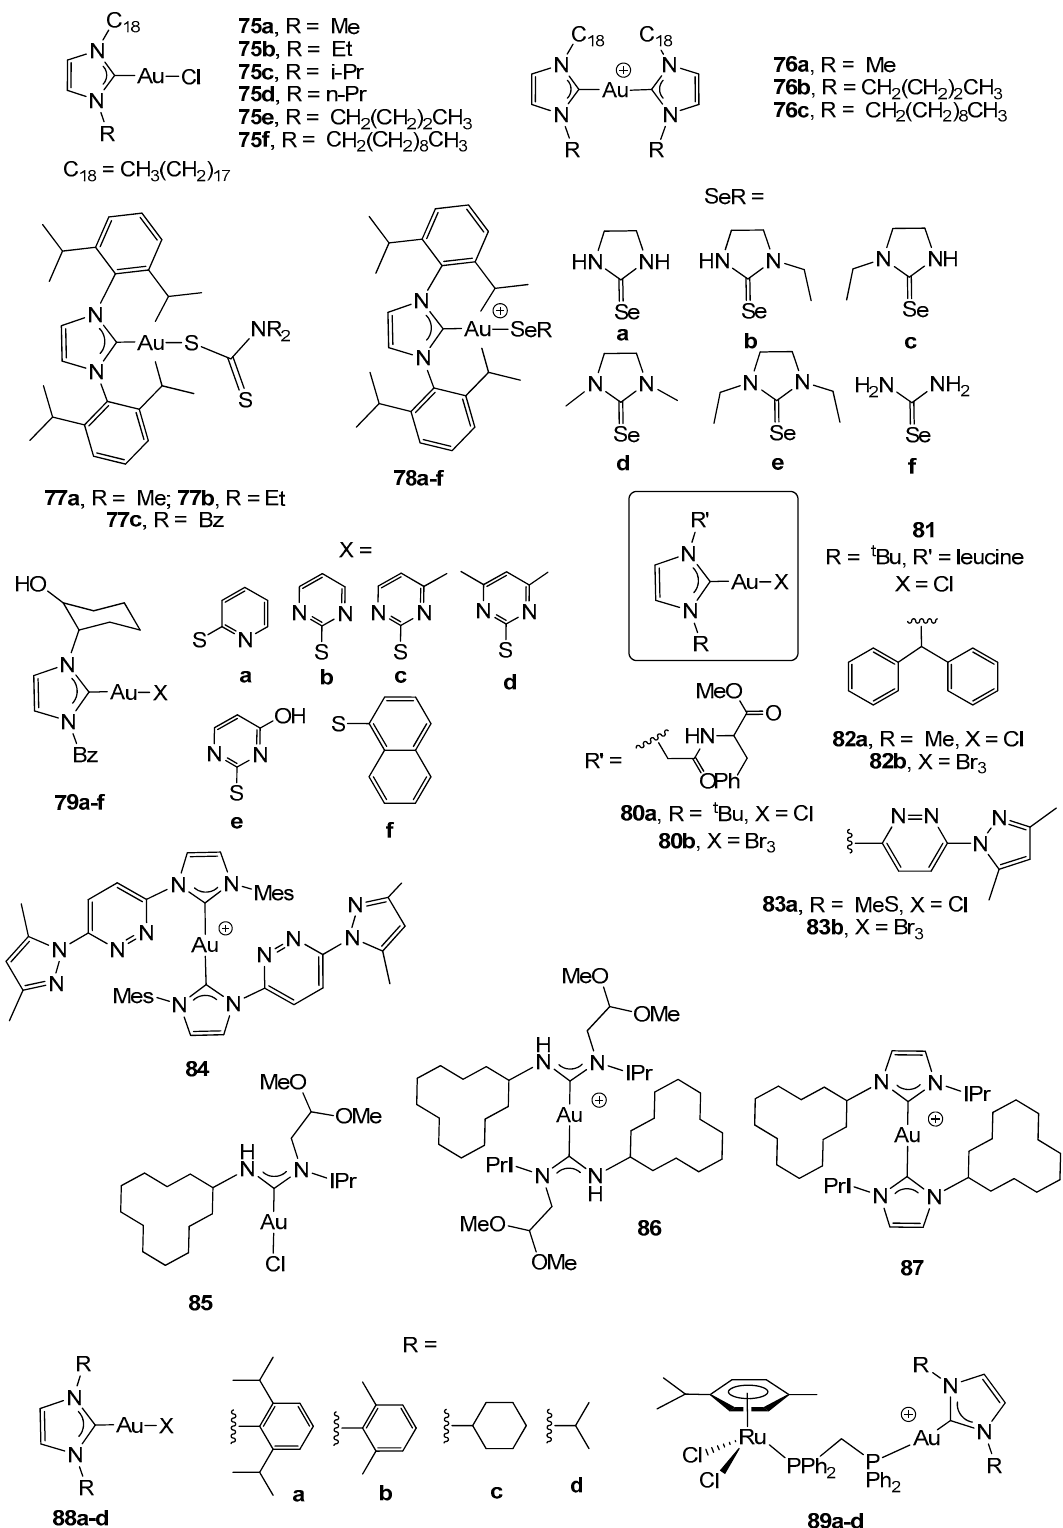
Figure 6. Structures of carbene gold(I) complexes.